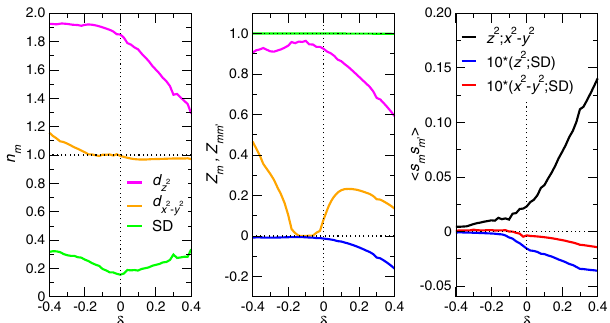
FIG. 13. Schematic sketch of the Ni- e with δ . The “ þ ” symbols denote a Fermi-sheet participation of x 2 − y 2 or z 2 , respectively, around M, Z, A or along k Brillouin zone.